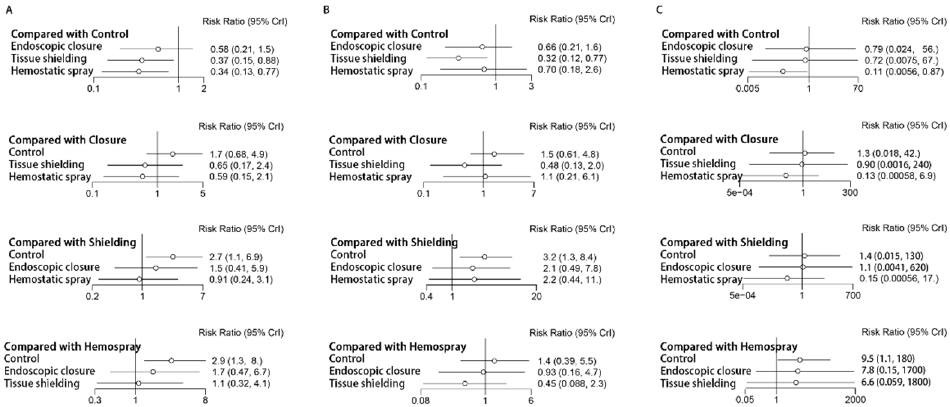
Figure 4. The efficacy of different endoscopic approaches for the prevention of delayed bleeding after gastric ESD, according to network meta-analysis: ( A ) in patients overall; ( B ) in high-risk patients; ( C ) in low-risk patients.